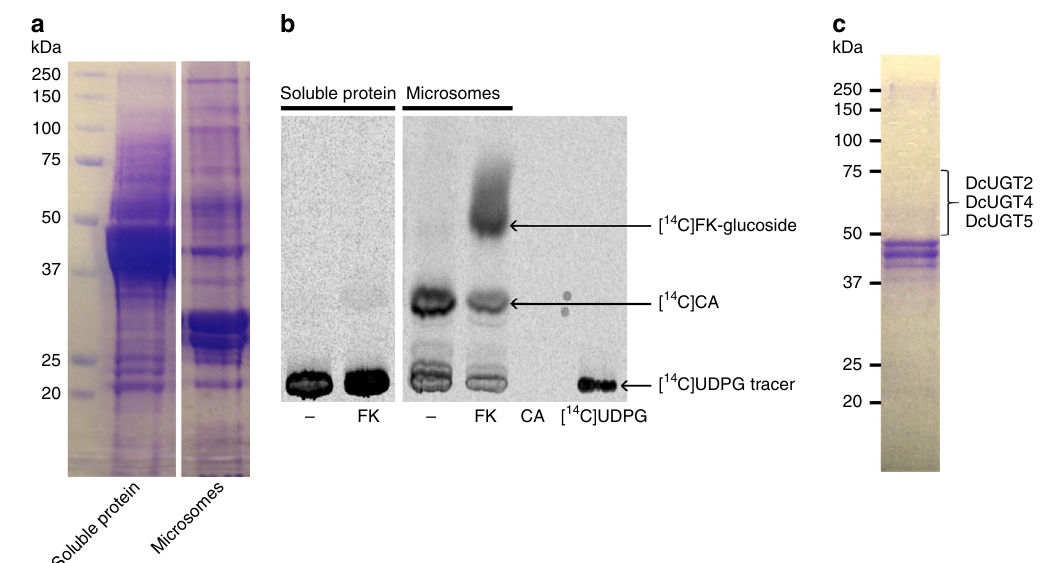
Fig. 2 Identi fi cation of a Dactylopius coccus FK/KA-speci fi c UGT activity. An isolated microsomal protein fraction and a soluble protein fraction from D. coccus were tested for glucosylation activity in vitro using the fl avokermesic acid aglucone and the [ 14 C]UDP-glucose donor. a Coomassie-stained SDS gel of separated microsomal/soluble protein from D. coccus . b TLC-separated [ 14 C]-labeled products, formed in vitro and monitored by phosphorimaging. [ 14 C]UDPG [ 14 C]UDP-glucose, FK fl avokermesic acid, CA carminic acid; − incubation without aglucone substrate. The in vitro formation of [ 14 C]CA was ascribed to the conversion of kermesic acid that still was bound to the D. coccus microsomes despite numerous wash steps during preparation. c A membrane-bound enzyme activity catalyzing the glucosylation of fl avokermesic acid and kermesic acid was partially puri fi ed by anion-exchange chromatography after solubilization with reduced Triton X-100 (Supplementary Fig. 1). A fraction eluted with 100 mM NaCl and enriched with fl avokermesic acid/kermesic acid-speci fi c glucosylation activity was separated on an SDS gel followed by Coomassie staining. Proteins within the apparent mass region of 50 – 75 kDa were in-gel digested with trypsin and analyzed by LC-MS/MS. Tryptic peptides of DcUGT2, DcUGT4 and DcUGT5